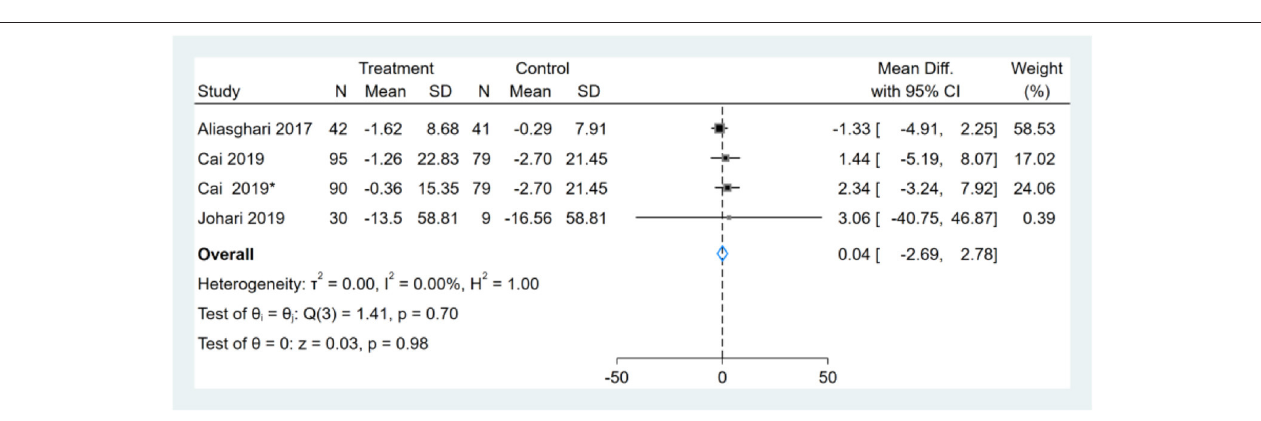
FIGURE 5 | Forest plot analysis showing changes in fasting blood sugar/glucose (FBS/GLU). *This study has two fasting intervention groups.